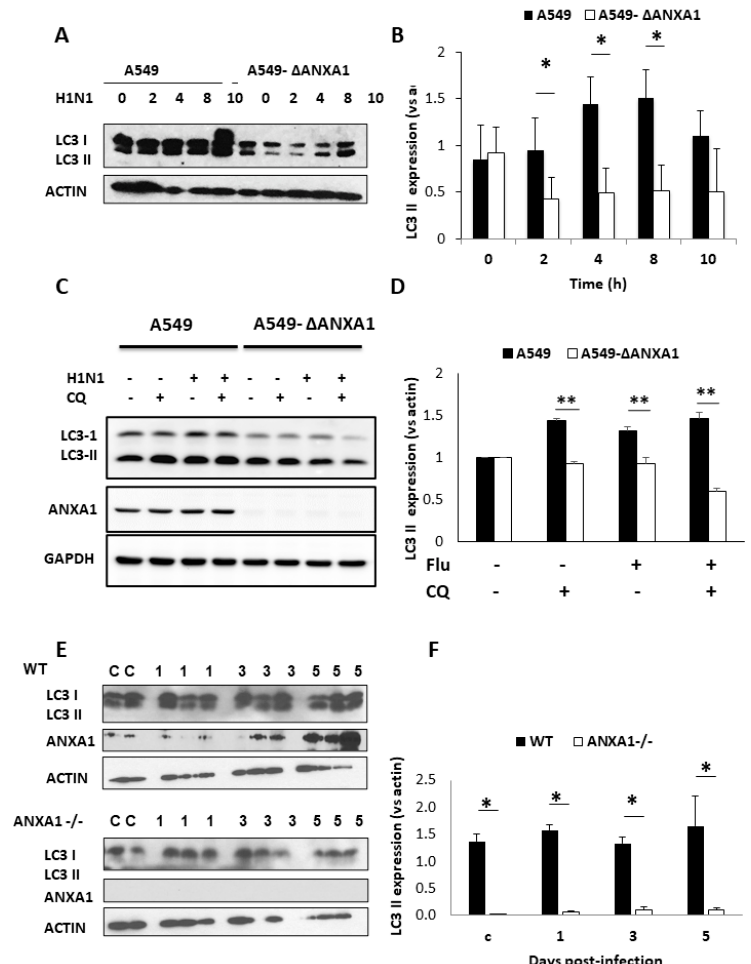
Figure 6. ANXA1 is involved in autophagy induced by influenza virus. ( A , B ) Cells were infected with H1N1 at 1 MOI over various time points (0, 2, 4, 8 and 10 h). Quantification of LC3-II expression using densitometric analysis. Data represent two independent experiments ( p < 0.05). ( C , D ) A549 and A549- Δ ANXA1 cells were infected with H1N1 at 1 MOI over 12 h, CQ 50 uM for 2 h. Quantification of LC3-II expression using densitometric analysis ** p < 0.01. ( E , F ) WT and ANXA1 − / − Balb/c mice were infected with 500 pfu of influenza virus intratracheally. On days 0, 1, 3 and 5 post-infection, the mice were sacrificed, and their lung lysates were obtained for Western blot analysis. * 0.01 < p < 0.05.